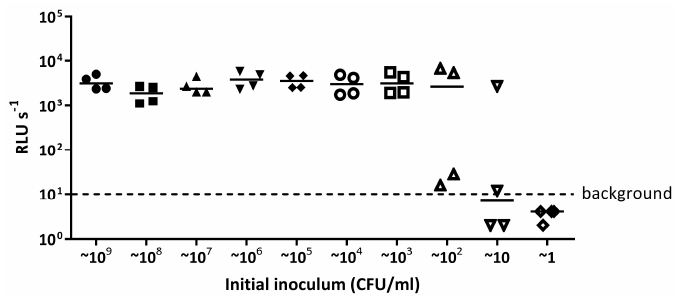
Figure A3. The limit of detection of E. coli 25922 lux when grown in a 96 well plate. E. coli 25922 lux was serially diluted in LB broth from ~10 9 CFU/mL to ~1 CFU/mL in a 96 well plate and incubated at 37 ◦ C for 16 h. Light release (RLU s − 1 ) was measured from each dilution and detectable light levels above 10 RLU s − 1 indicates growth. The data presented are from four independent experiments. Materials 2018 , 11 , x FOR PEER REVIEW